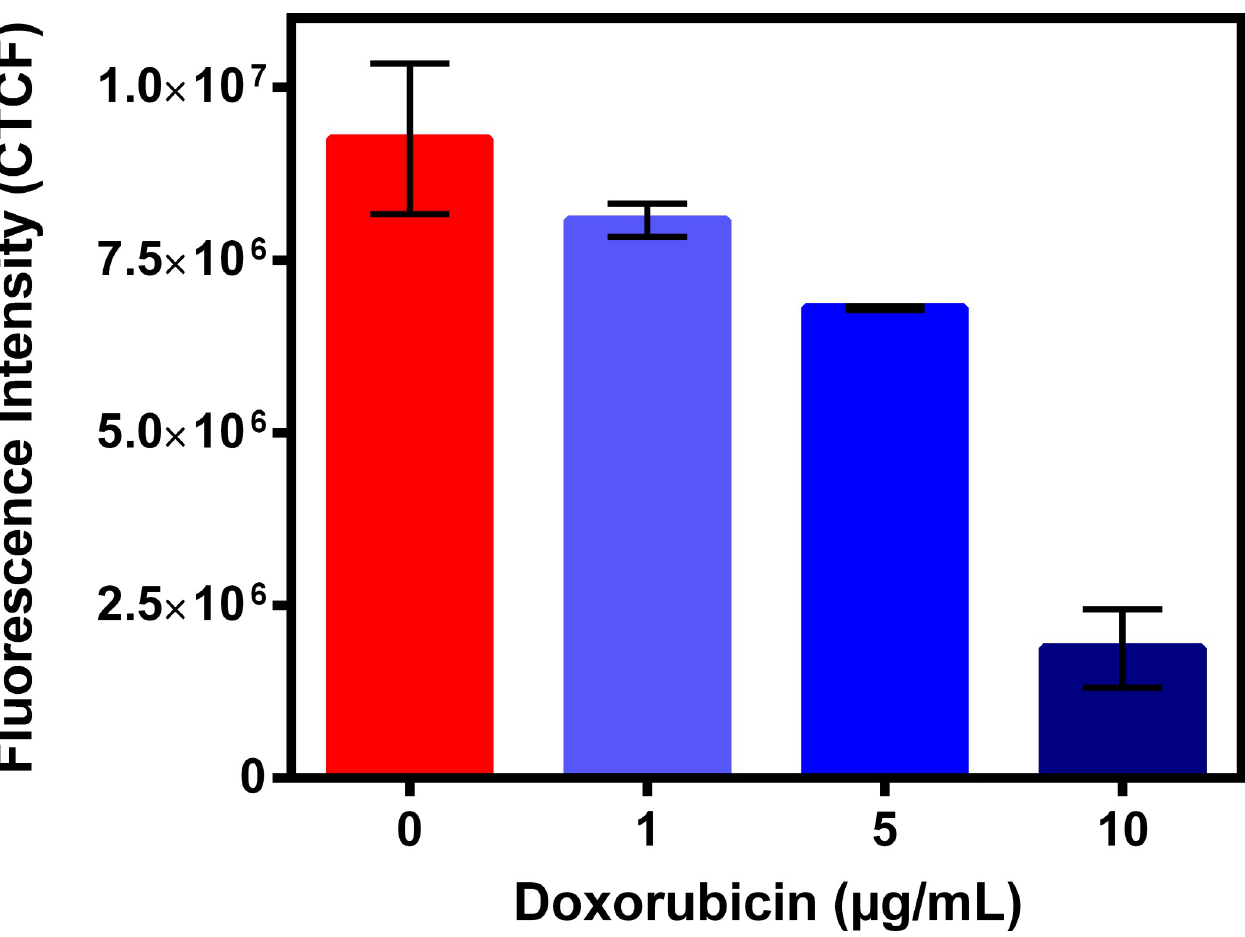
Fig 6. DOX induced cardiomyopathy in rat cardiomyocytes cells. H9c2 cells were treated with DOX (0, 1, 5 and 10 μ g/mL) for 24h and uptake of Galmydar (20 μ M, 60 min) was determined using fluorescence imaging. Corrected Total Cell Fluorescence (CTCF) = Integrated Density–(Area of selected cell X Mean fluorescence of background readings); (mean ± SEM, H (3, N = 3) 9.45, p = 0.02, Kruskal-Wallis).